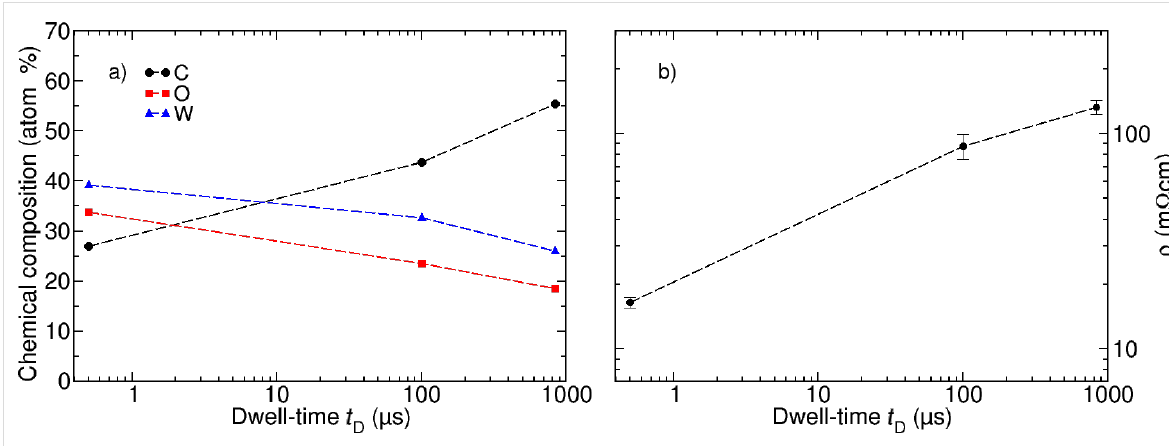
Figure 4: (a) Chemical composition of sample 1 ( t D = 100 μ s), sample 2 ( t D = 0.5 μ s) and sample 3 ( t D = 831 μ s). EDX measurements were performed on separate 2 × 2 μ m 2 samples. (b) Resistivity of samples 1, 2 and 3: By solely varying the deposition parameters dwell-time and pitch as obtained from the GA experiments, the resistivity of W–C–O samples can be tuned by one order of magnitude.